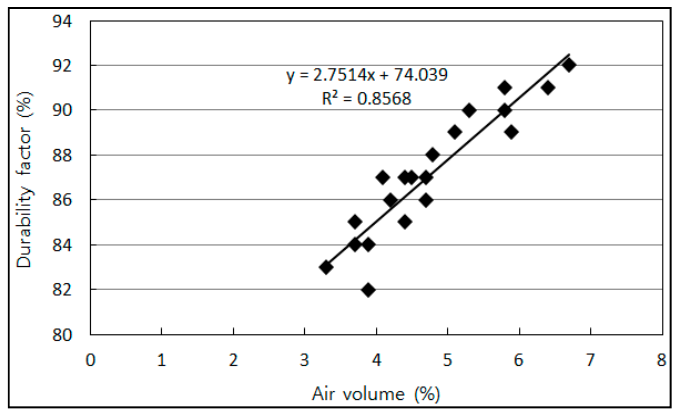
Figure 13. Relationship between durability and air volume.